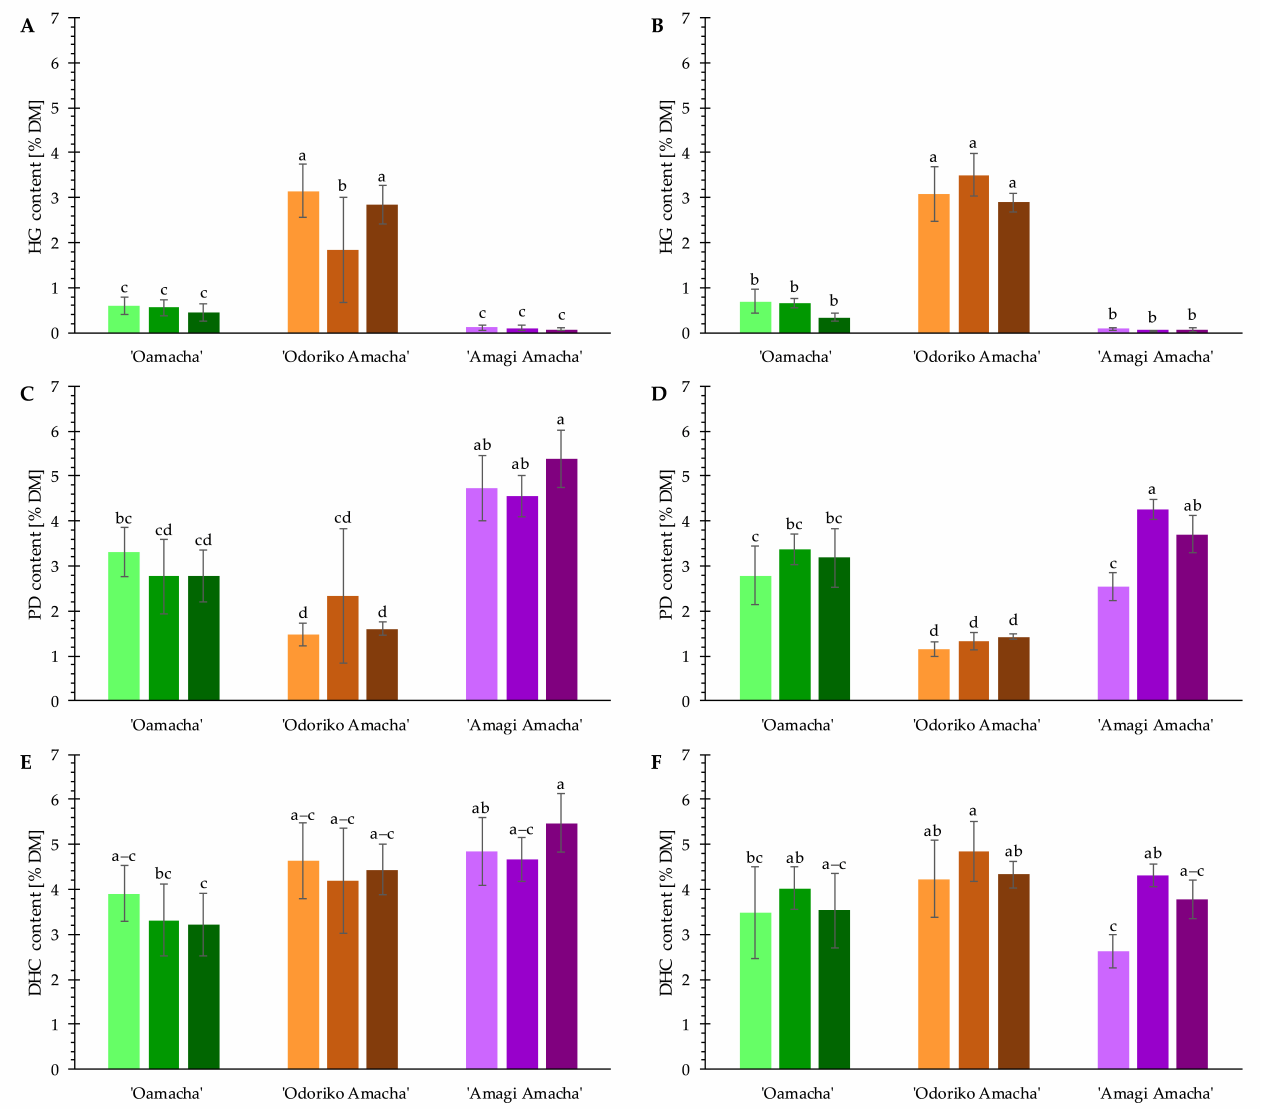
Figure 5. Content (%) of ( A , B ) hydrangenol (HG), ( C , D ) phyllodulcin (PD) and ( E , F ) dihydroisocoumarin (DHC) in leaf dry matter of H. macrophylla subsp. serrata cultivars (green: ‘Oamacha’, orange: ‘Odoriko Amacha’, purple: ‘Amagi Amacha’) in two different years (( A , C , E ): 2018 and ( B , D , F ): 2019) at the end of two growing periods under three different light conditions (bright coloring: no shade, light coloring: partial shade, dark coloring: full shade). Significant differences within a year and constituent calculated by ANOVA and Tukey HSD (n = 5, α = 0.05) are indicated by letters (a–d). ANOVA tables can be found in the Supplementary Materials Table